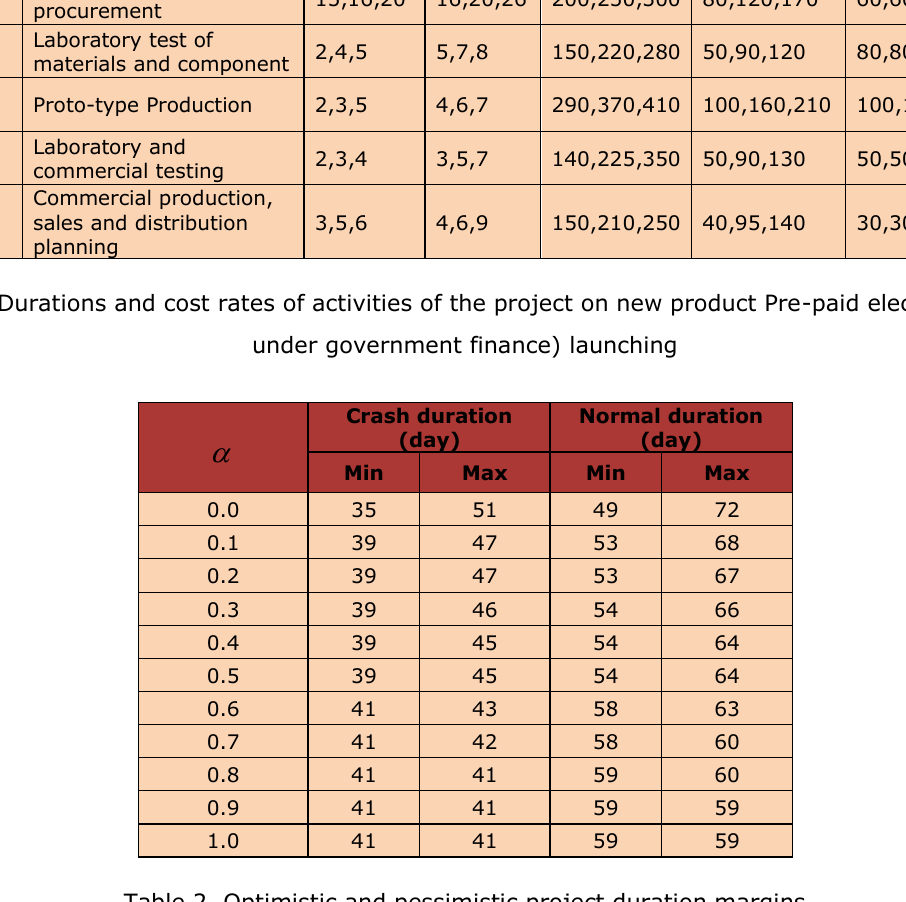
Table 2. Optimistic and pessimistic project duration margins